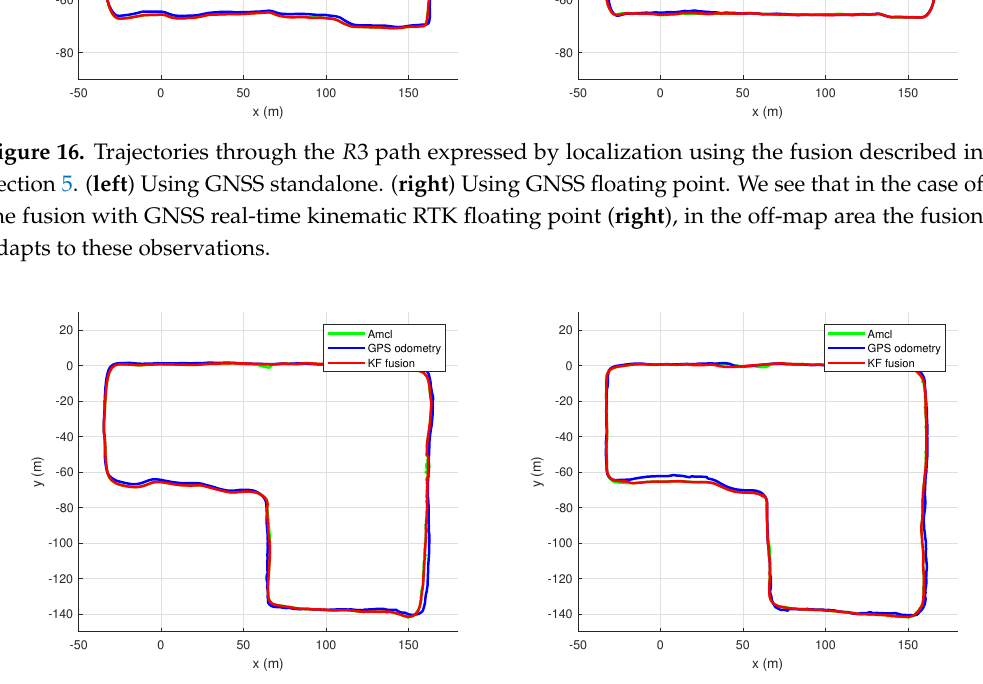
Figure 17. Trajectories through the R 4 path expressed by localization using the fusion described in Section 5. ( left ) Using GNSS standalone. ( right ) Using GNSS floating point. In this case, the whole area x > 50 m is off-map. We see that in both cases we can make the re-entry on the map. However, in the case of the GNSS RTK floating point ( right ) the trajectory seems more consistent except in the curve located in the lower right quadrant, where conditions were very unfavorable due to occlusions and multi-path produced by trees and